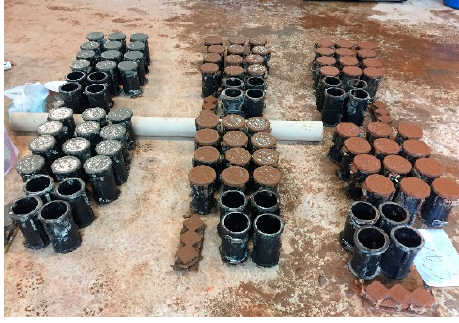
Figure 4. Fabrication of concrete specimens.